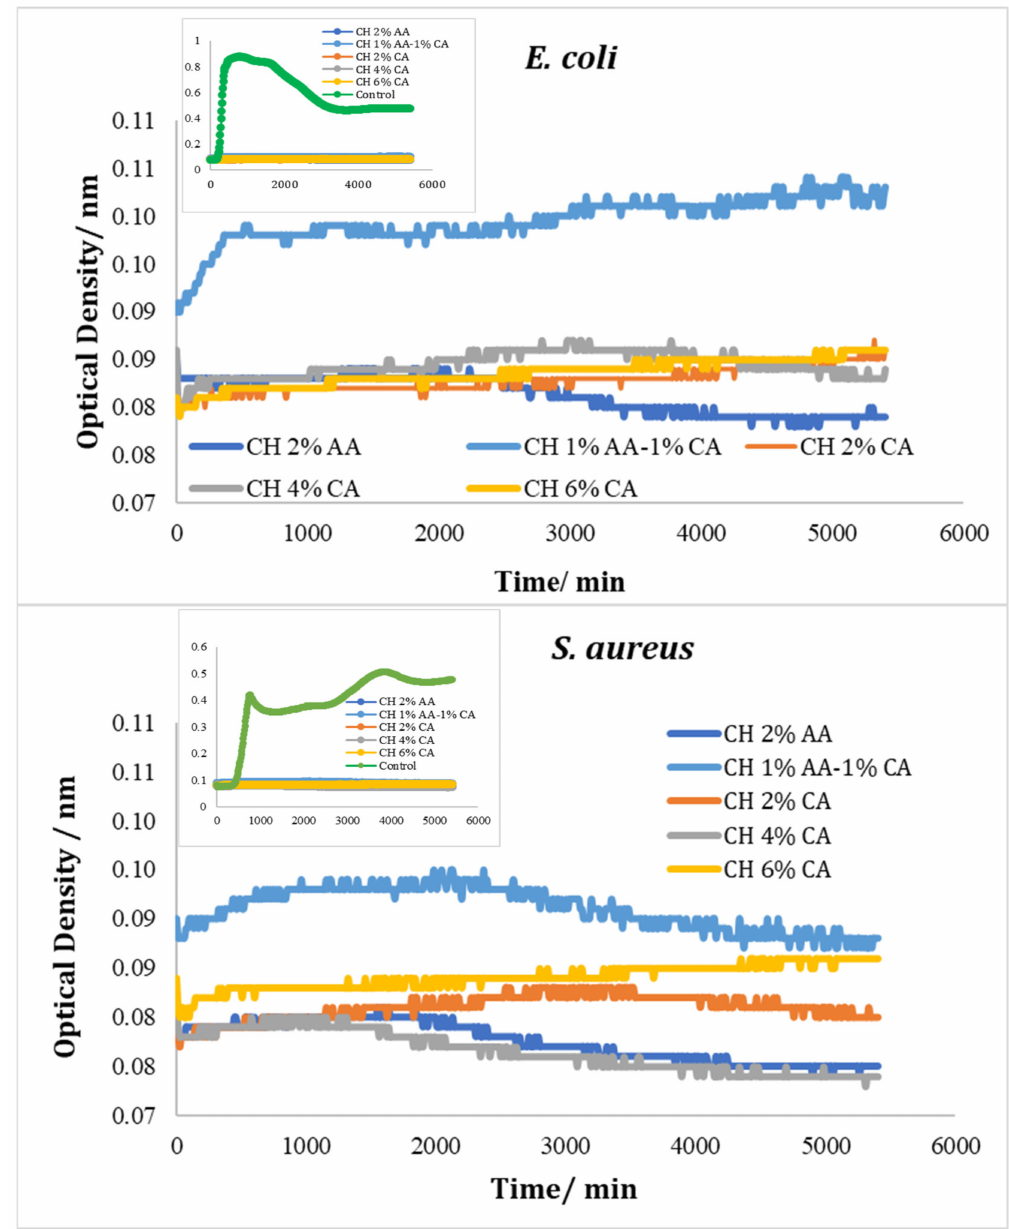
Figure 10. Growth curves of E. coli and S. aureus with different added chitosan concentrations in AA and CA solutions. All data points are averages of three parallel samples, with error bars representing standard deviation. The small inserted figures show the growth curves of the chitosan solution against the control, showing Abs (600 nm) from 0.07 to 0.11